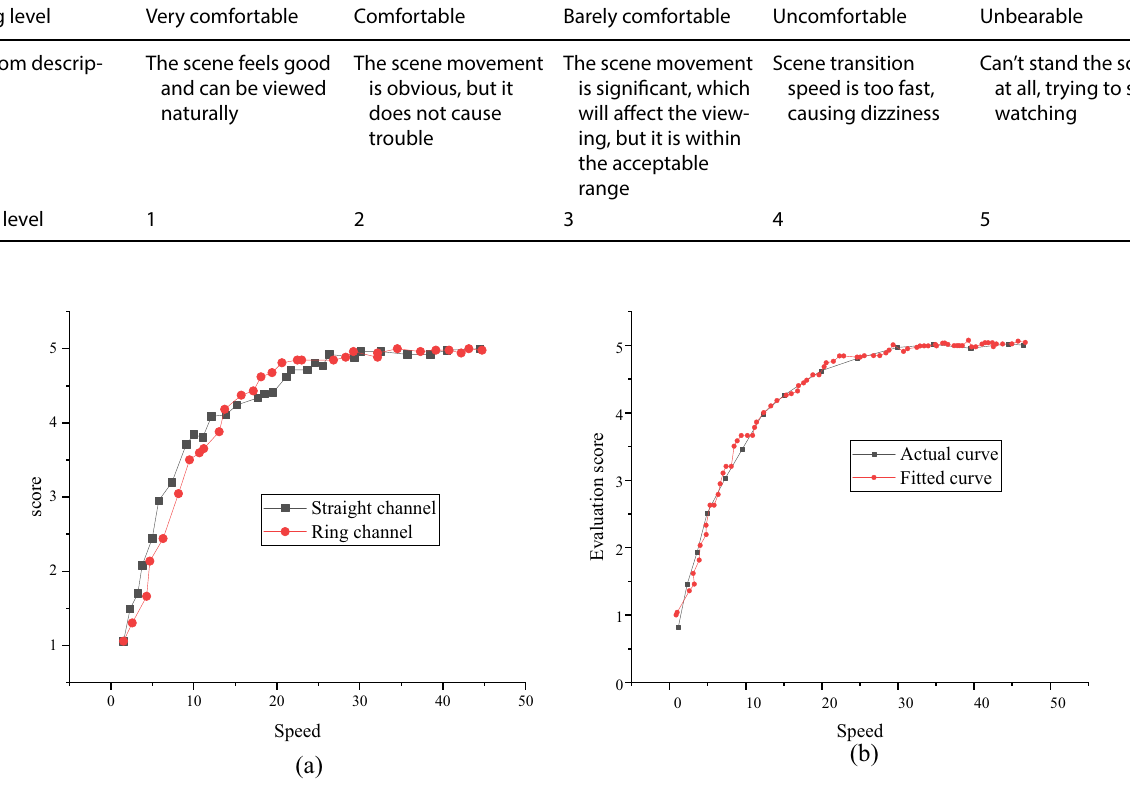
Fig. 3 Dizziness of VR scene moving forward in a straight line ( a the comparison results under the scenes of the straight-line channel and curve channel; b the curve fitting